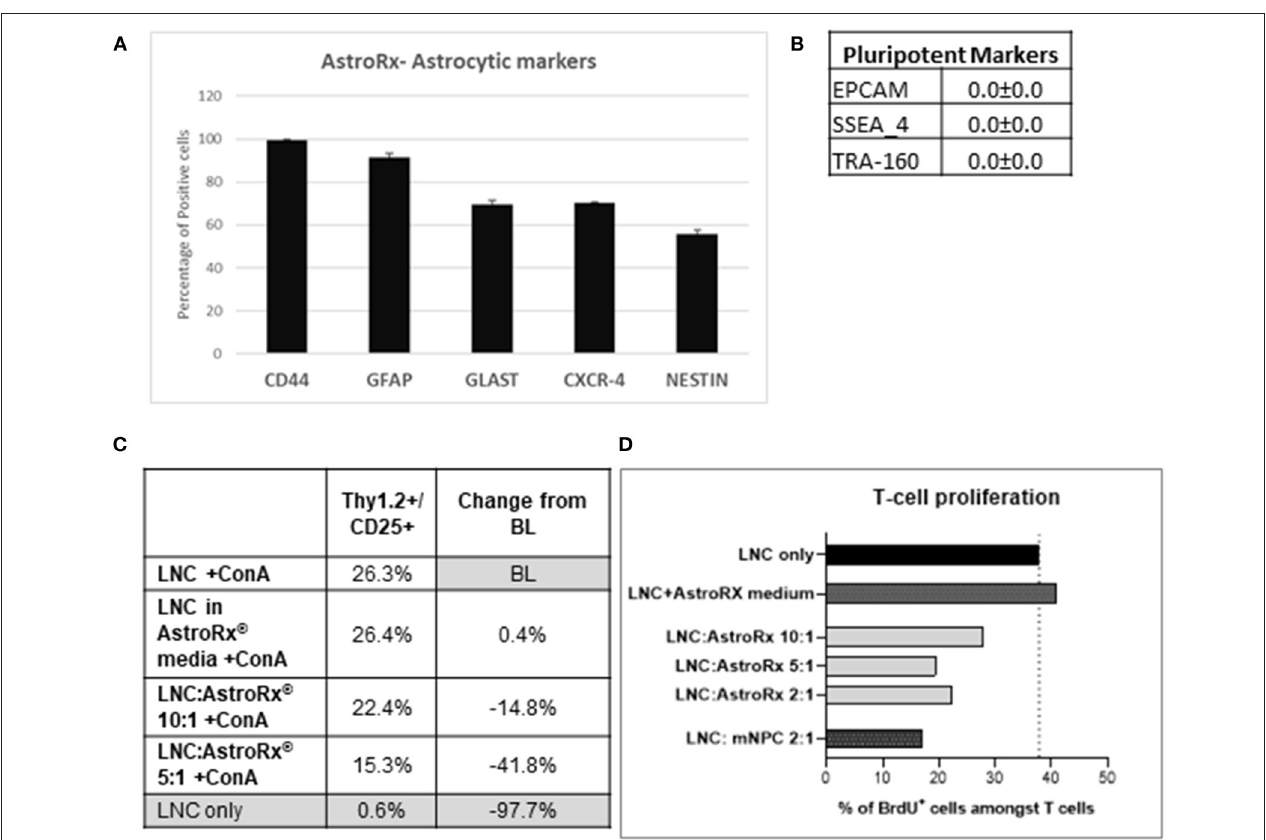
FIGURE 1 | Human astrocytes (AstroRx) demonstrate immunosuppressive capacities in vitro . (A,B) The AstroRx were analyzed by flow cytometry for astrocytic markers (A) and pluripotent stem cells markers (B) . (C,D) The immunosuppressive potential of AstroRx was assessed in a mixed lymphocyte reaction test. The AstroRx were co-cultured with murine lymph node cells (LNCs). (C) The LNCs were stained for T cell marker Thy1.2 and CD25 positive cells under ConA activation in the presence or absence of different amounts of AstroRx. (D) The proliferation state of T cells (CD3 + ) was determined by the proliferation marker BrdU in the presence of ConA. The LNCs only were used as negative control while the LNC with mouse neural precursor cells (mNPC) were used as a positive control. Average and ±